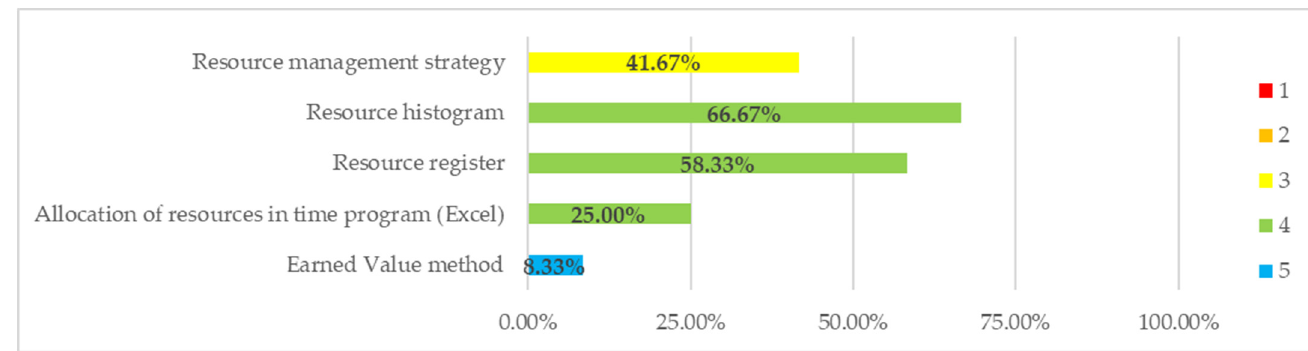
Figure 6. Evaluation of the effectiveness of the methods, techniques and tools used for the resource control process. Source: own elab.